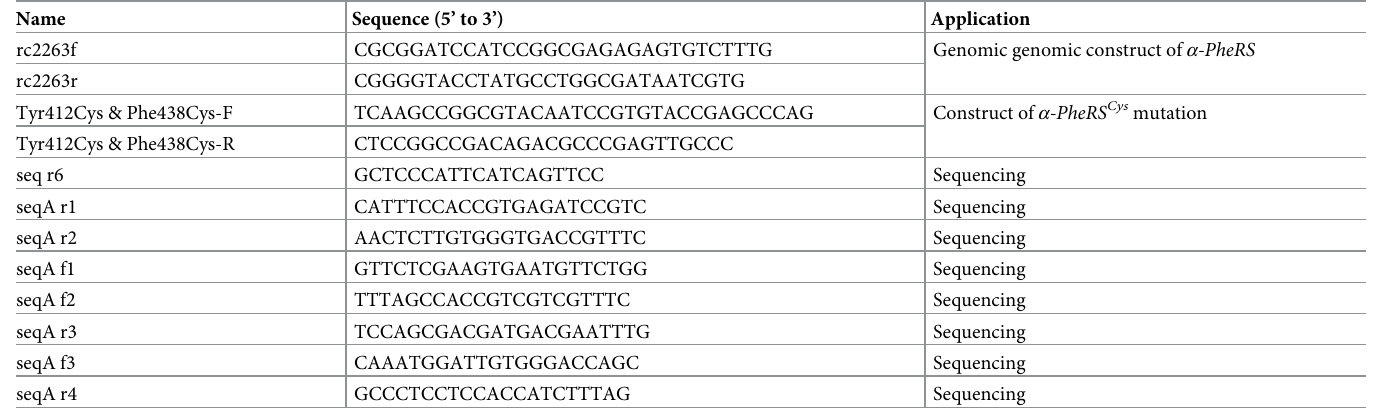
Table 3. Primers.